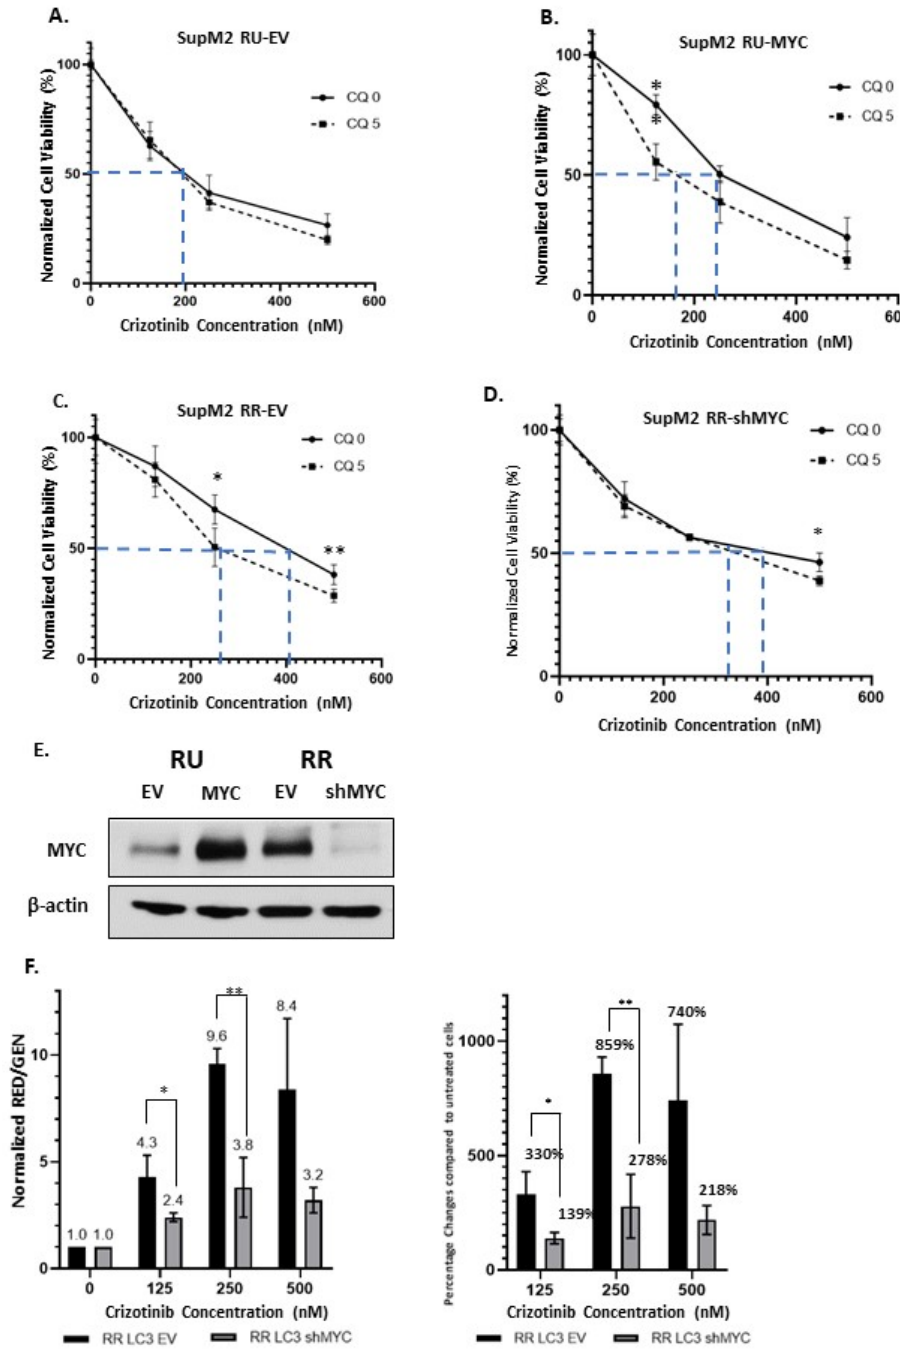
Figure 4. MYC regulates autophagy in ALK-positive anaplastic large cell lymphoma (ALK + ALCL) cells treated with crizotinib. ( A – D ) Cell viability after treating with different dosages of crizotinib (0, 125, 250, 500 nM) for 24 h following the modulation of MYC. The MYC protein expression level was modulated by using a MYC overexpression plasmid (into RU cells, A , B ) or a shRNA against MYC (into RR cells, C , D ). ( E ) Western blot to confirm the expression of MYC in SupM2 RU and RR cells. ( F ) The RED/GEN ratio and the normalized percentage changes with crizotinib treat- ment (0, 125, 250, 500 nM) for 24 h after knockdown of MYC by shRNA in SupM2 RR-LC3 cells. Original blots are shown in Figure S4. Data from three independent experiments and shown as mean ± standard deviation (SD), n = 3, * p < 0.05, ** p < 0.01, Student’s t